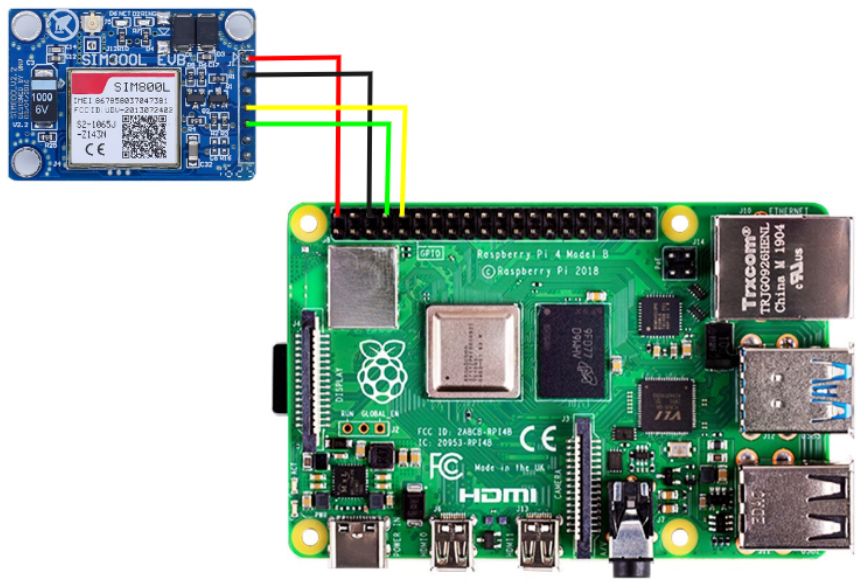
Figure 8. GSM with controller for sending